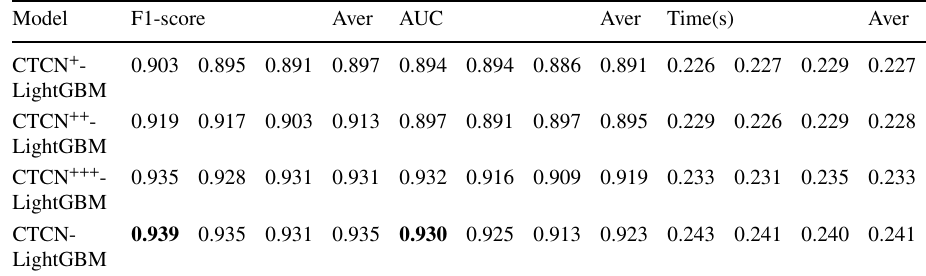
The bold values indicate superior metric values of the proposed CTCN-LightGBM